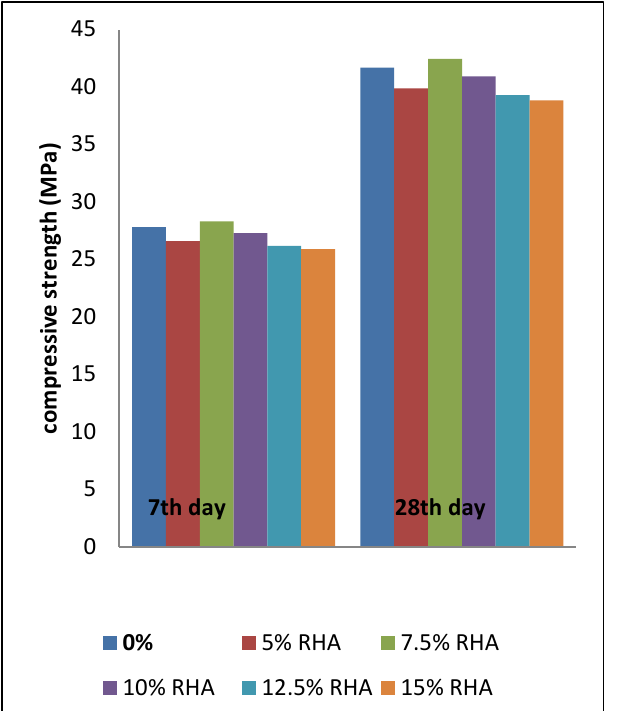
Table 6: Bar graphs showing compressive strength of M-40 mix at different % levels of RHA